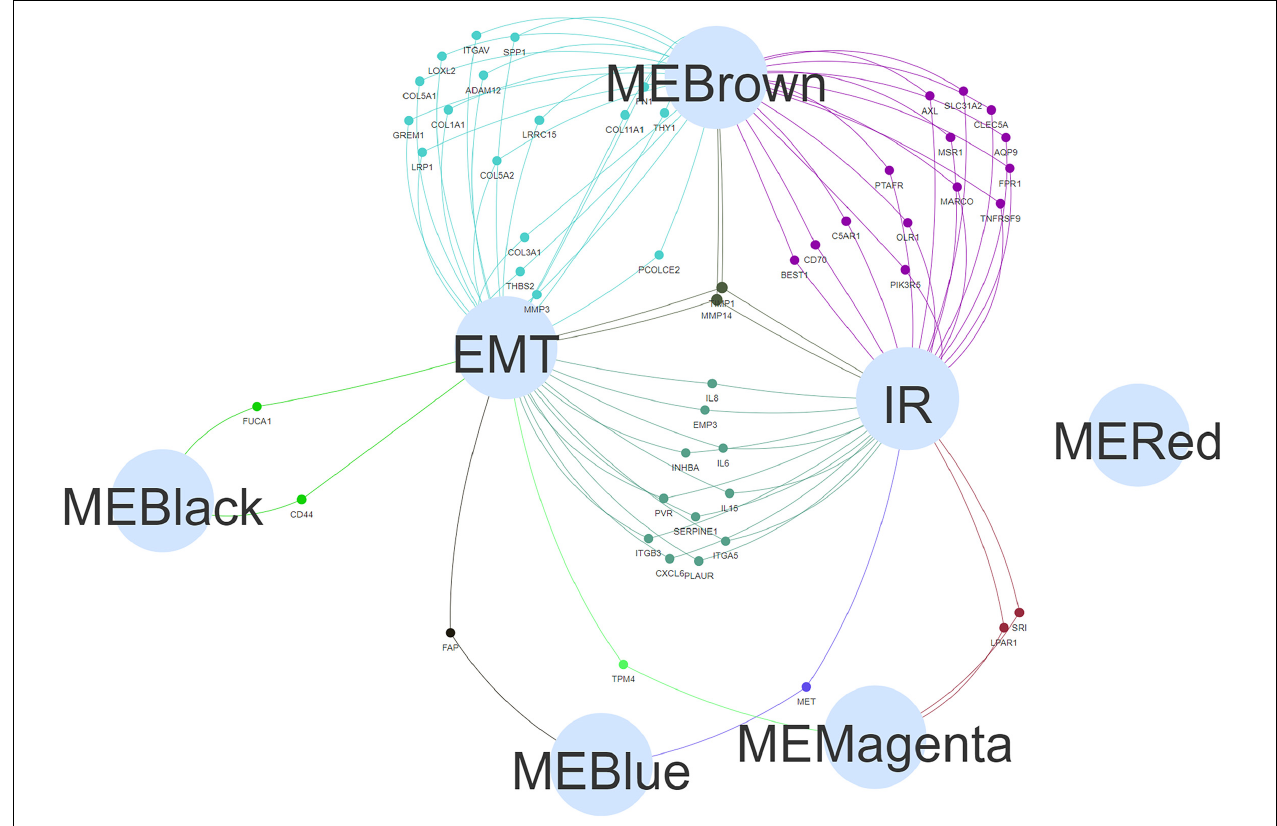
FIGURE 3 | The Venn diagram showing the intersection of five module genesets (“MEBrown,” “MEBlack,” “MERed,” “MEBlue,” and “MEMagenta”) and hallmark genesets [epithelial–mesenchymal transition (EMT) and inflammatory response